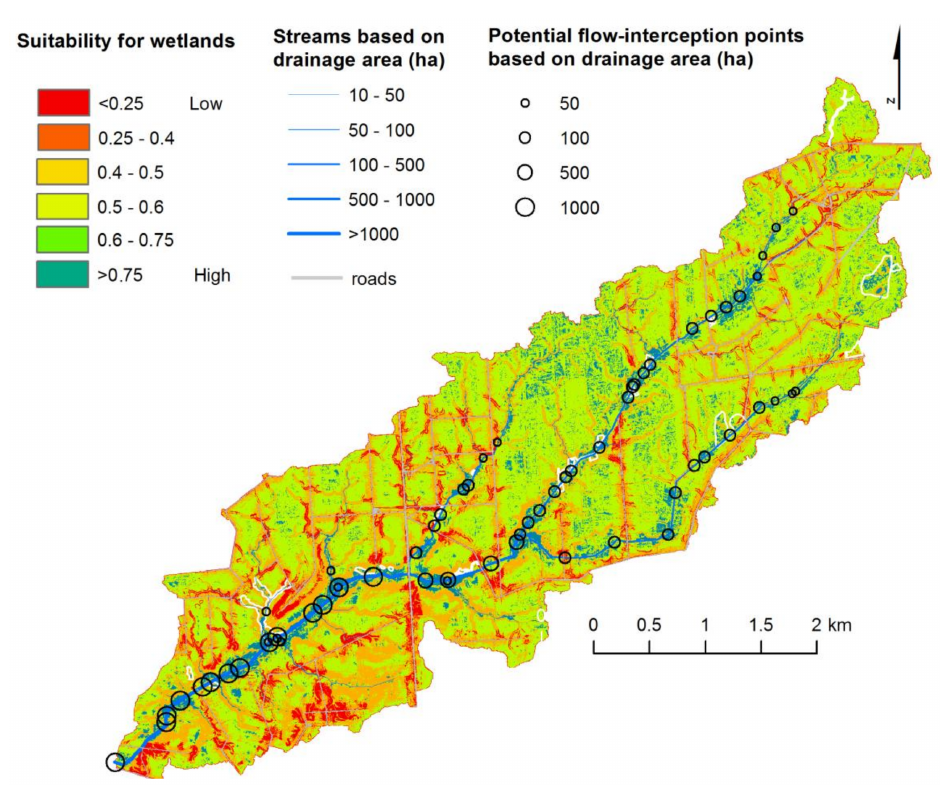
Figure 5. Final suitability map for wetlands and the potential flow-interception locations based on the size of the drainage area and the four criteria-based suitability maps in Figure 4. The existing wetlands that were identified from orthophotos are colored